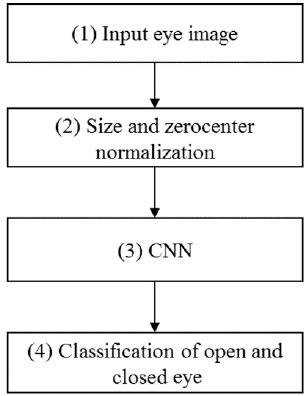
Figure 1. Overview of the procedure implemented by the proposed method.